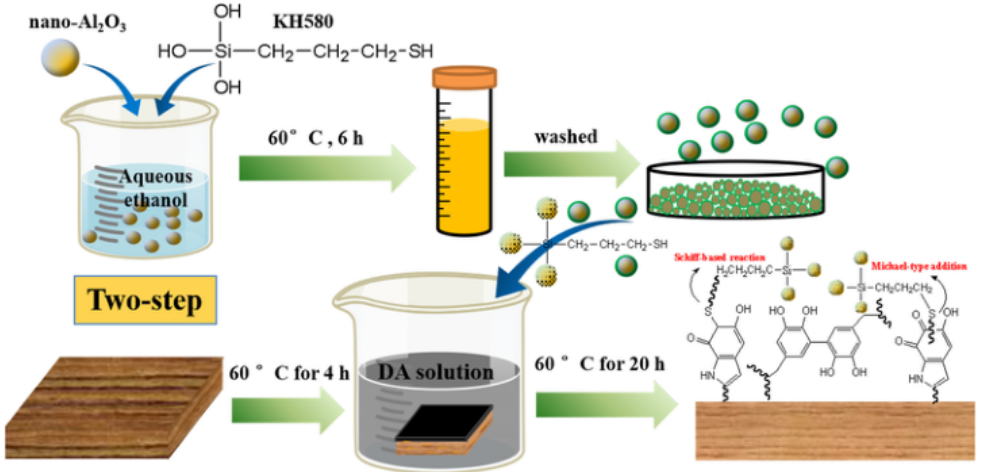
Figure 8. Schematic diagram of one-step [88].